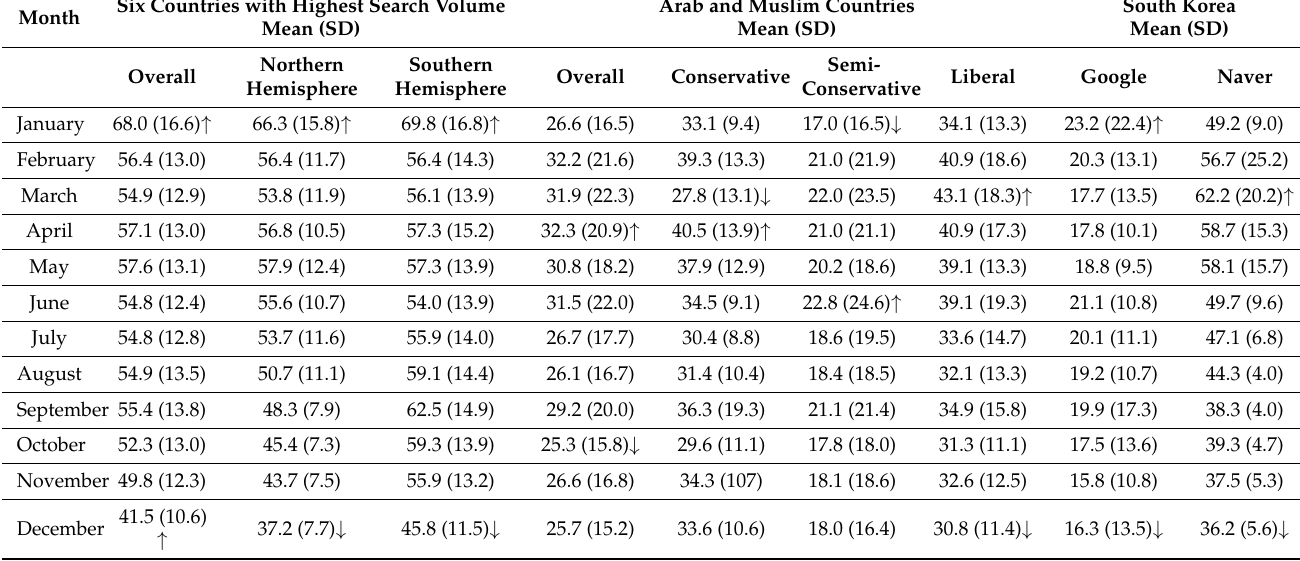
Table 2. Comparison of the search volume of diet by month among study